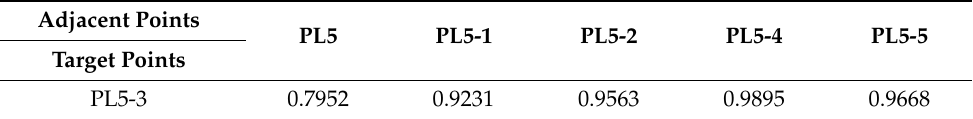
Table 1. Correlation results of deformation sequences of target measurement points and adjacent measurement points.